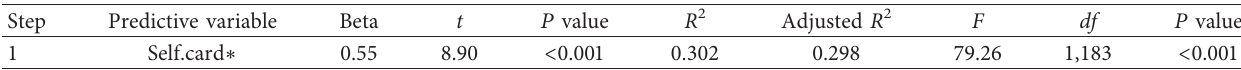
Table 5: Factor affecting nurses’ performance regarding organ donation.